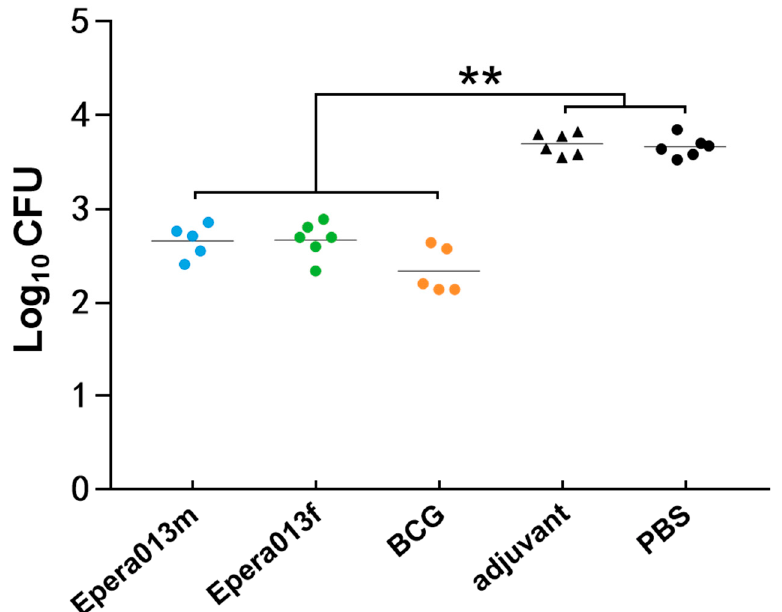
Figure 7. Efficacy analysis of splenocytes from Epera013f, Epera013m and BCG immunized mice in the inhibition of MTB growth ex vivo ( n = 6 for each group, mean values ± S.E.M.). Values were from three independent experiments. One-way ANOVA followed by LSD (Least Significant Difference) multiple comparison test was performed for the comparison among Epera013f, Epera013m, BCG groups and blank/negative controls (PBS/adjuvant groups) (** p < 0.01). CFU, colony-forming unit. Triangles and circles correspond to the horizontal coordinates: blue circles refer to Epera013m group, green circles refer to Epera013f group, yellow circles refer to BCG group, black triangles refer to adjuvant group, black cirles refer to PBS group.